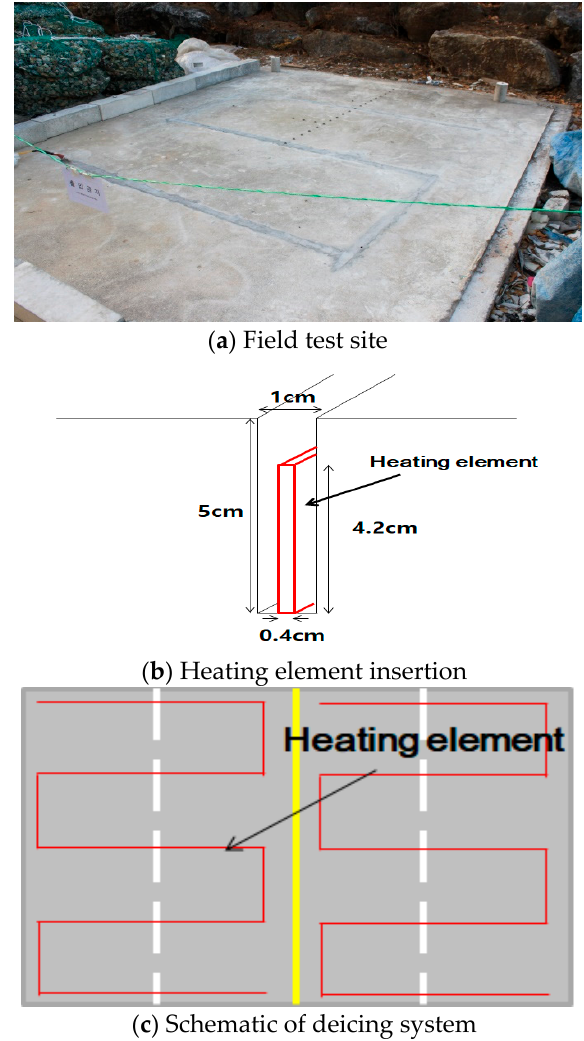
Figure 11. Overview of field test procedure.